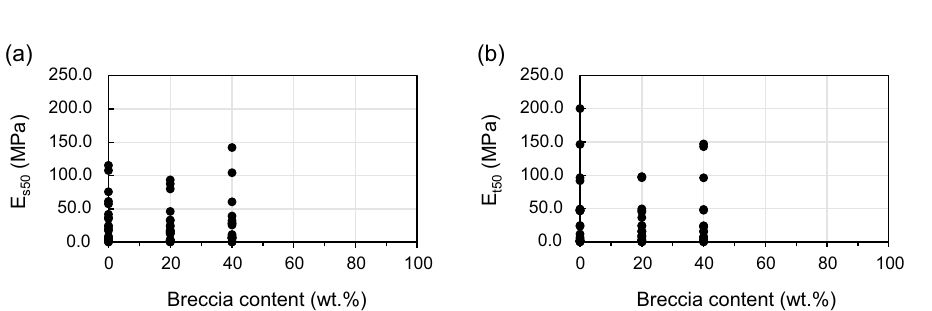
Figure 12. Effect of breccia content on ( a ) the secant modulus at 50% ultimate strength (E s50 ) and ( b ) the tangent modulus at 50% ultimate strength (E t50 ) of artificial fault-core-zone